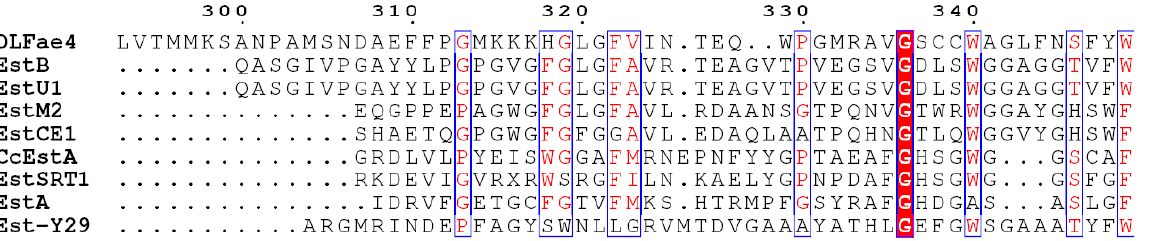
Figure 4. Enzymatic synthesis of esters and carbonates by DLFae4 or variant DLFae4 (A341G). Results showed that esters and carbonates were synthesized by DLFae4 and DLFae4 (A341G) with different reaction rates (Figure 5). The conversion rates of esters and car- bonates were gradually increased with the extension of reaction time, and no product hy- drolysis was detectable even after 12 h, indicating all the reactions appear to be irreversi- ble. The benzyl acetate formation from benzyl alcohol and vinyl acetate was very fast, with more than 90% conversion rate within 50 min, and the reaction time decreased by 30 min as compared with variant DLFae4 (A341G) and DLFae4. The benzyl methyl carbonate formation from benzyl alcohol and dimethyl carbonate was slower than that of benzyl acetate. The highest conversion rate of variant DLFae4 (A341G) was accomplished within 120 min while DLFae4 required an extra 80 min as achieved the same conversion rate, indicating the faster reaction rate and stronger transacylase activity of variant DLFae4 (A341G).